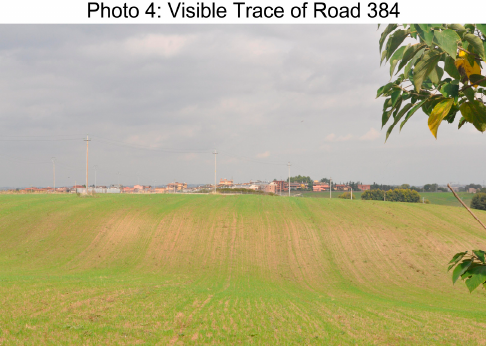
Figure 35. Photograph acquired of the location of a part of Road 384, situated in the center of the broad valley visible in the photograph. The photograph was acquired on 6 October 2015 at 12:36 CET.